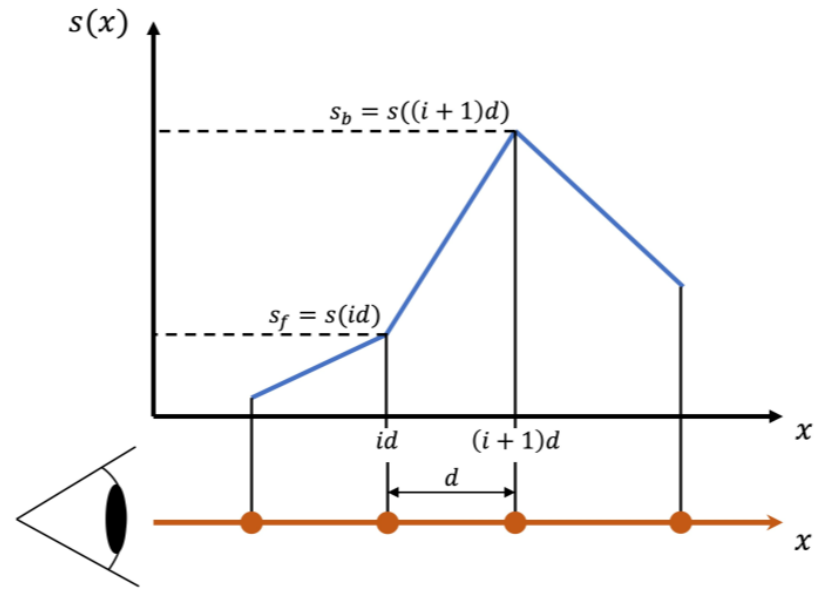
Figure 11. Pre-integration piecewise linear sampling principle.